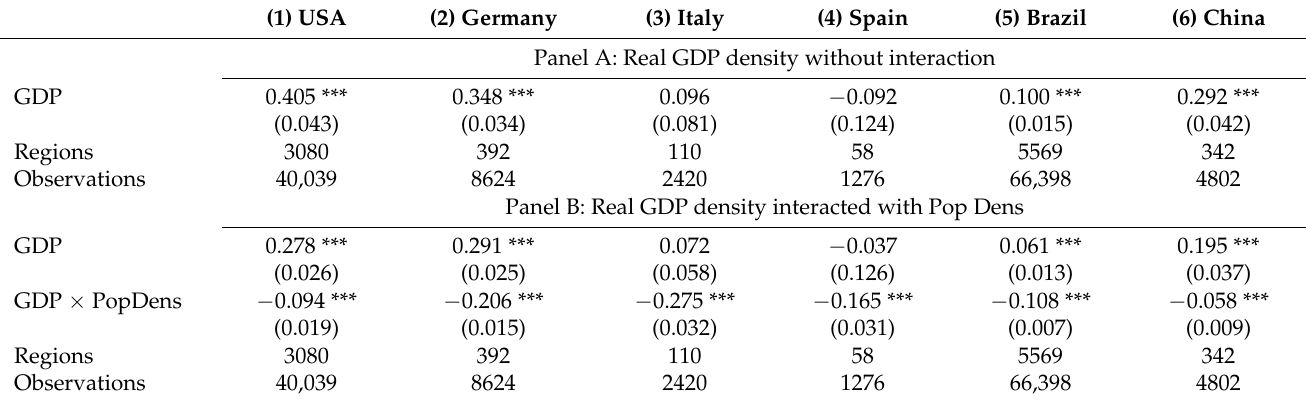
Table 3. Income elasticity of nighttime lights by population